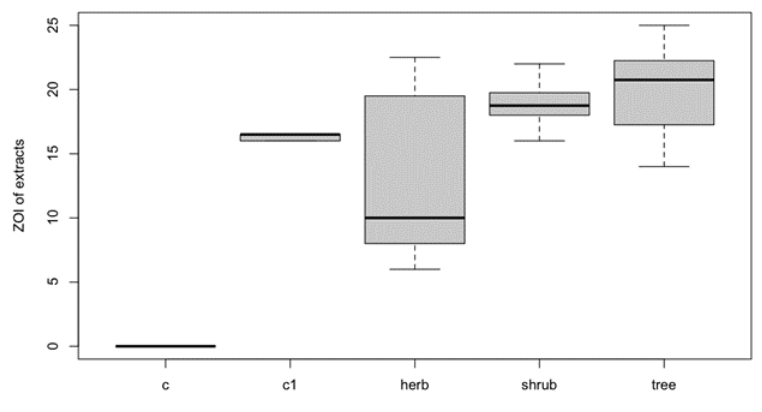
Figure 6 e zone of inhibition (mm) of aqueous and ethanol extracts in terms of plant